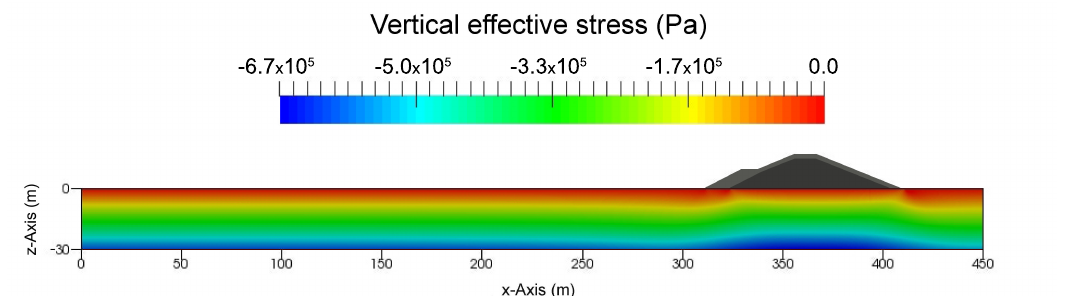
Figure 7. Vertical effective stress σ (cid:48) z at the end of the consolidation process concerning a breakwater with submerged berm with h b / h t = 0.19 and L b / L w =